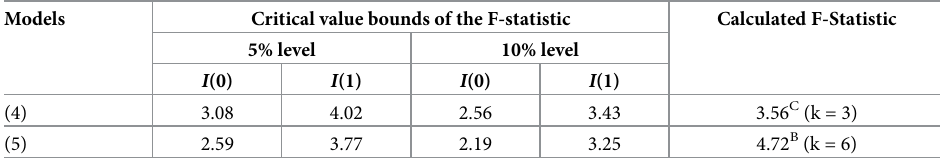
A, B, C indicate significance at 1, 5 and 10 percent levels. The F-statistic values are compared to the critical values by Narayan [31]. k is the number of regressors.